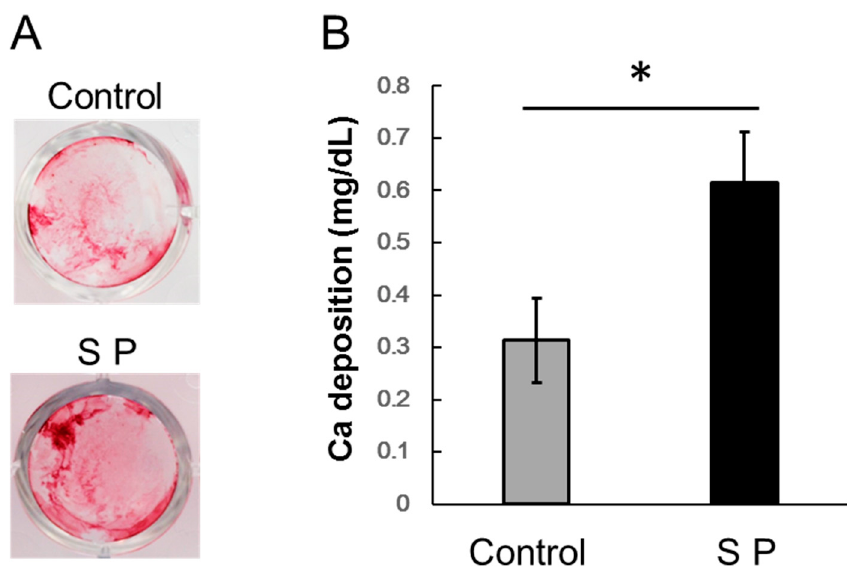
Figure 4. Effect of SP on mineralization in KN-3 cells. ( A ) Alizarin Red staining for detection of calcified nodule formation, ( B ) Measurement of extracellular matrix calcium